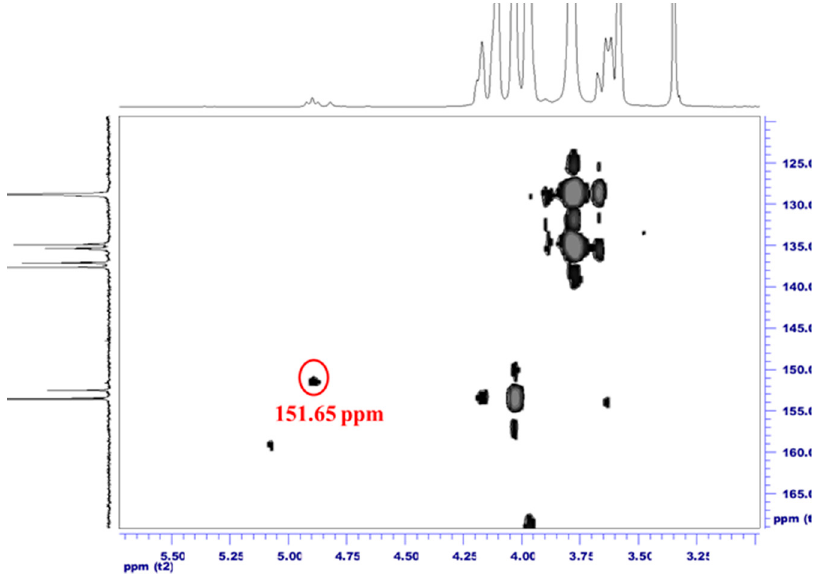
Figure 8. 1 H– 13 C HMBC NMR of PFD/PU-03.